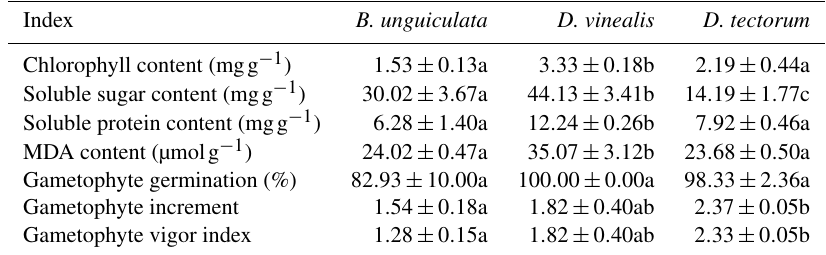
Figure 1. Data (average ± 1SE) for the three moss species on (a) gametophyte germination and (b) gametophyte increment after the 40-day storage period at each of the five temperatures. Different letters indicate significant differences ( P < 0 . 05) among the five temperatures within the same species. Dotted lines represent the approximate values of the two germination parameters before storage for each species (the true values are shown in Table 1). Table 1. Initial values of physiological indices and germination parameters in the three mosses. Index B. unguiculata D. vinealis D.